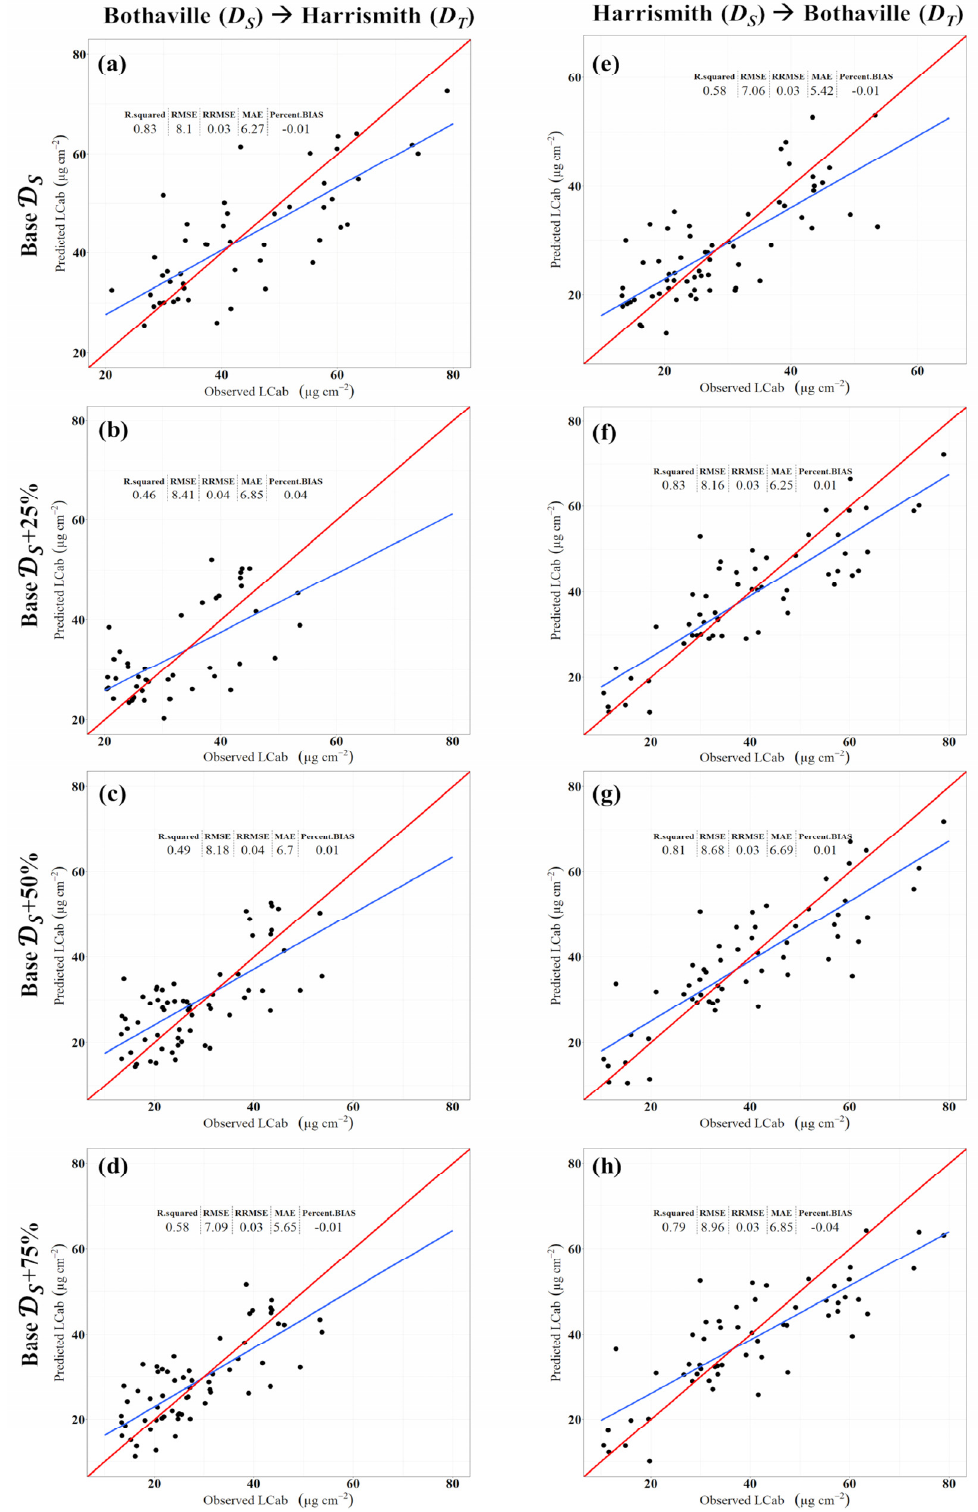
Figure 4. Scatterplots for Leaf Chlorophyll Content (LC ab , µg cm − 2 ) indicating the performance of the XGBoost models in the Source 𝒟 (cid:3020) and Target 𝐷 (cid:3021) sites considering scenarios where only 25% (Base 𝒟 (cid:3020) + 25%, ( b , f ), 50% (Base 𝒟 (cid:3020) + 50%, ( c , g ), and 75% (Base 𝒟 (cid:3020) + 75%, ( d , h ) of the training samples are available in the Target 𝐷 (cid:3021) site. Base 𝒟 (cid:3020) models for cases where Bothaville and Harrismith are the Source sites 𝒟 (cid:3020) are shown in panels ( a , e ), respectively. The 1:1 and the regression lines between the observed and predicted values are shown in red and blue, respectively.